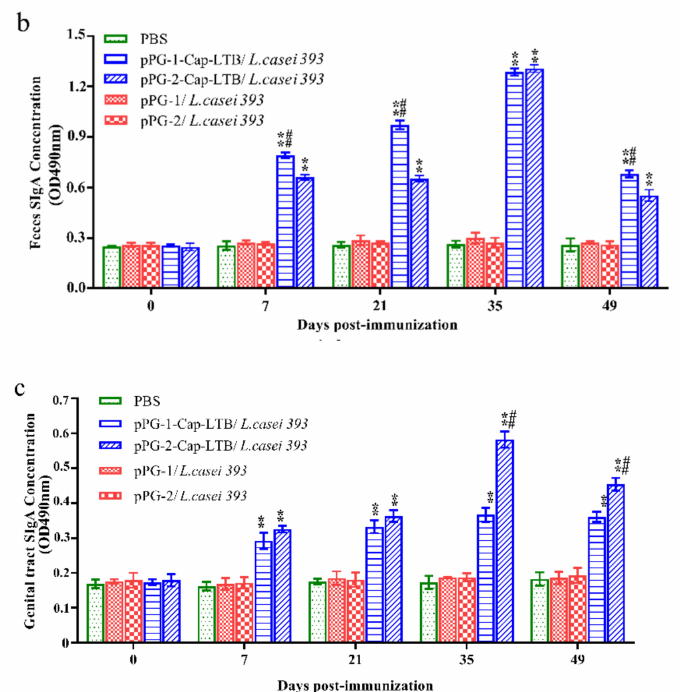
Figure 4. Specific IgA antibody levels in mice post-immunization. Determination of anti-PEDV mucosal SIgA antibody in ( a ) feces, ( b ) intestinal mucus, and ( c ) vaginal wash by ELISA using PCV2 as the coating antigen. Bars represent the mean ± standard error of each group (* p < 0.05, ** p < 0.01 compared to the control groups: pPG-1/ L. casei 393 and # p < 0.05, ## p < 0.01 compared to group: pPG-2/ L. casei 393 ).